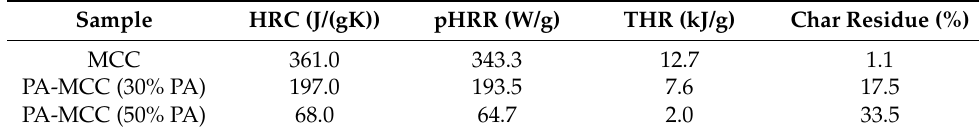
Figure 2. FT-IR ( a ), TG ( b , c ), and PCFC ( d ) analyses of PA-MCC obtained at various concentrations of PA. (PA concentration: 30% and 50%; MCC/PA weight ratio: 1:3; PA/urea/dicyandiamide weight ratio: 15:1:2; 90 ◦ C; 4 h). Table 1. PCFC data of PA-MCC obtained at various concentrations of